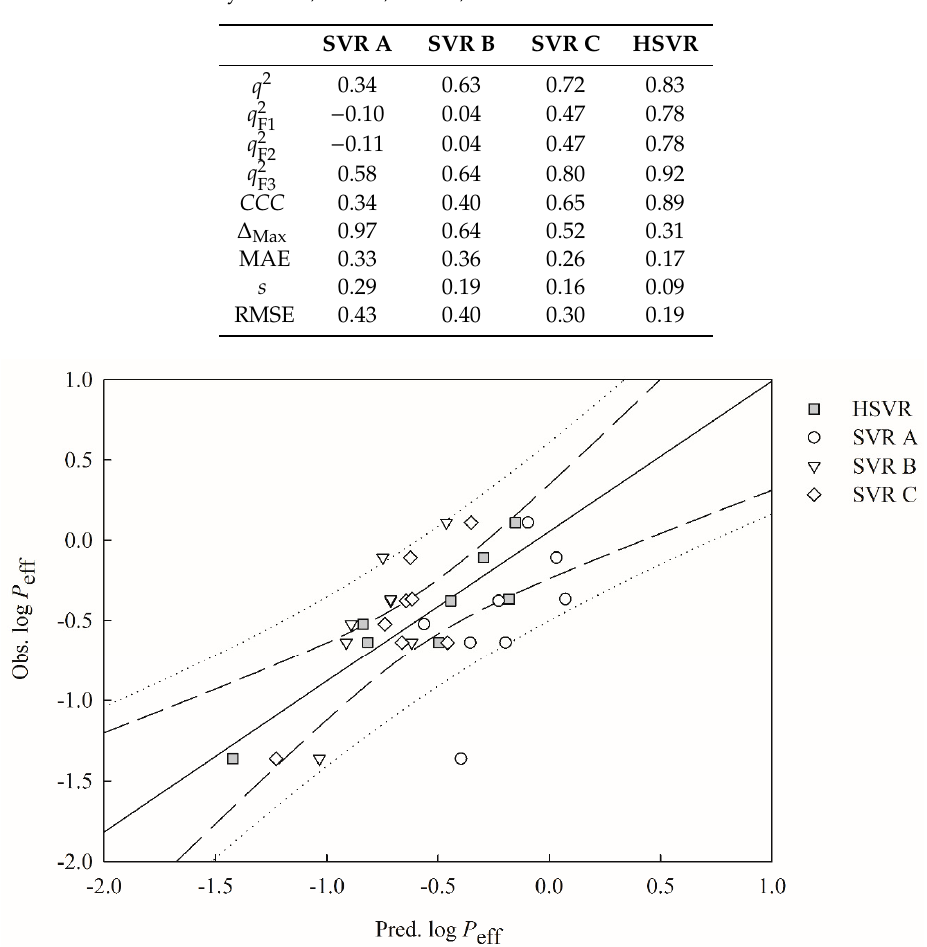
, q 2 , and q 2 , concordance correlation F1 F2 F3